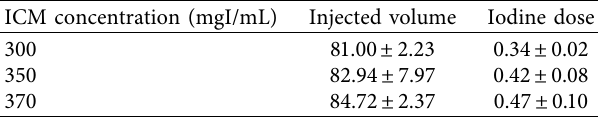
Table 5: Concentration and volume of injected